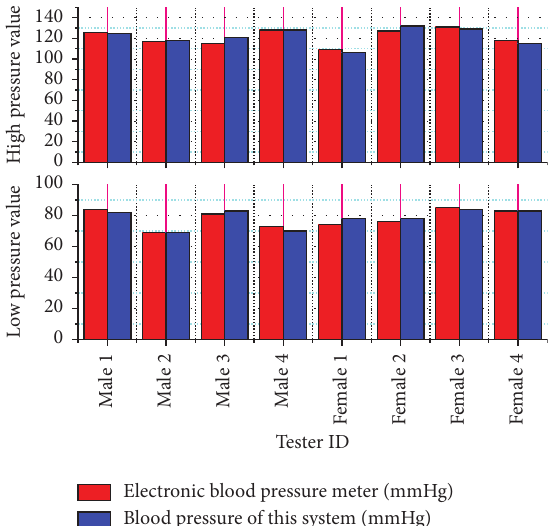
Figure 3: Comparison of blood pressure collection